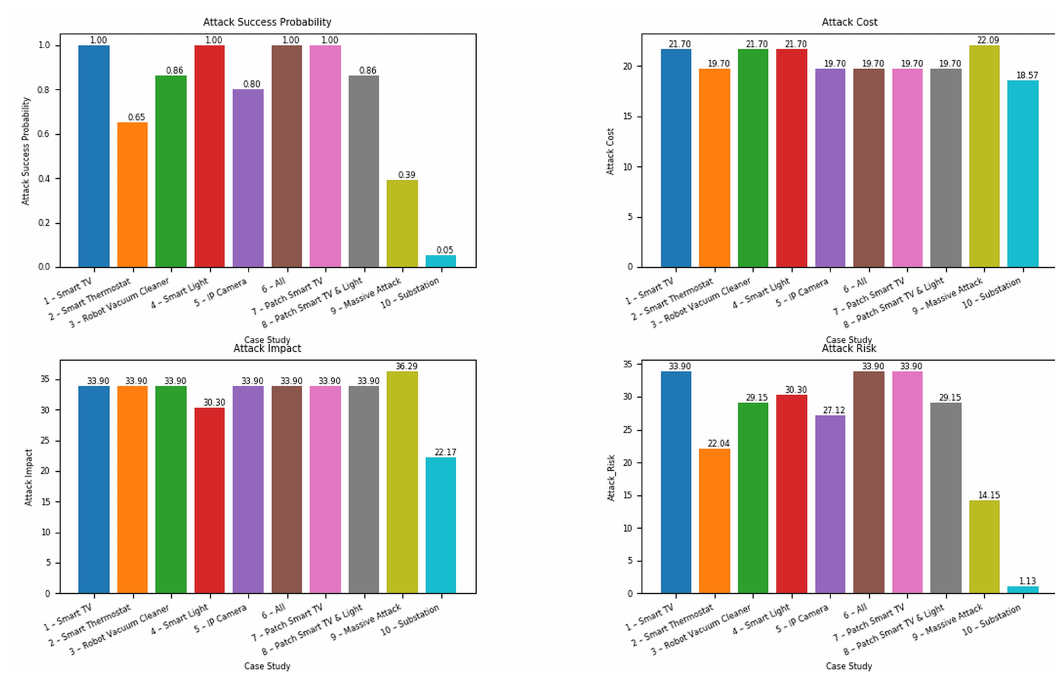
Figure 7. An example of attack analysis result